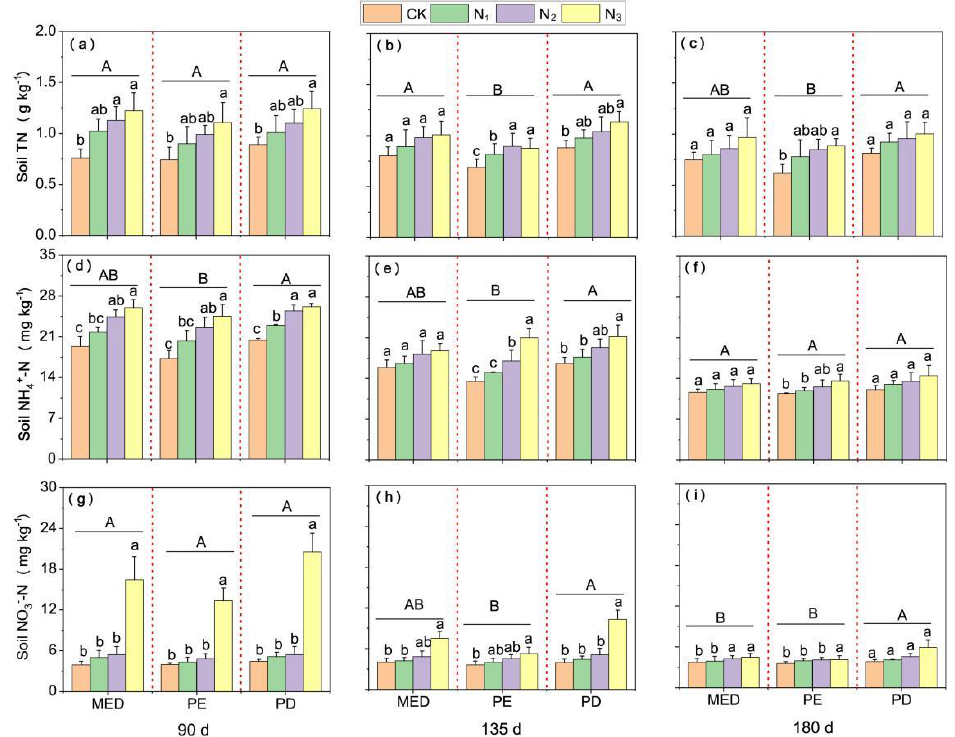
Figure 7. Concentrations of TN ( a – c ), N-NH 4+ ( d – f ) and N-NO 3 − ( g – i ) in the soil at days 90, 135 and 180. The different lowercase letters above the bars indicate significant differences ( p < 0.05) in concentrations of TN, NH 4+ -N and NO 3 − -N in the soil among the N treatments. MP = E. urophylla × grandis mixed together with D. odorifera plantations; PE = pure E. urophylla × grandis plantations; PD = pure D. odorifera plantations. The different capital letters on the straight lines indicate significant differences in the concentrations of TN, NH 4+ -N and NO 3 − -N in the soil among planting systems ( p < 0.05). CK indicates plants without N application, and N 1 , N 2 and N 3 correspond to N fertilizer application rates of 3, 6 and 12 g urea (CO( 14 NH 2 ) 2 ) pot −1 , respectively. Error bars indicate ± SE ( n = 4).